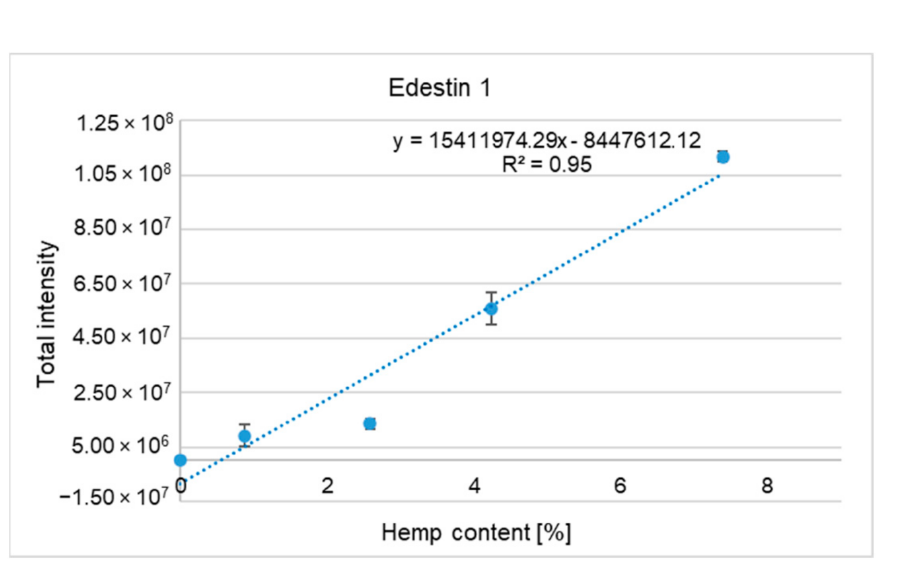
Figure 2. Trend line obtained for the hemp-seed-specific protein edestin 1 (CDP79023.1) from protein digests of meatballs containing 0%, 0.9%, 2.6%, 4.2%, and 7.4% hemp cake,